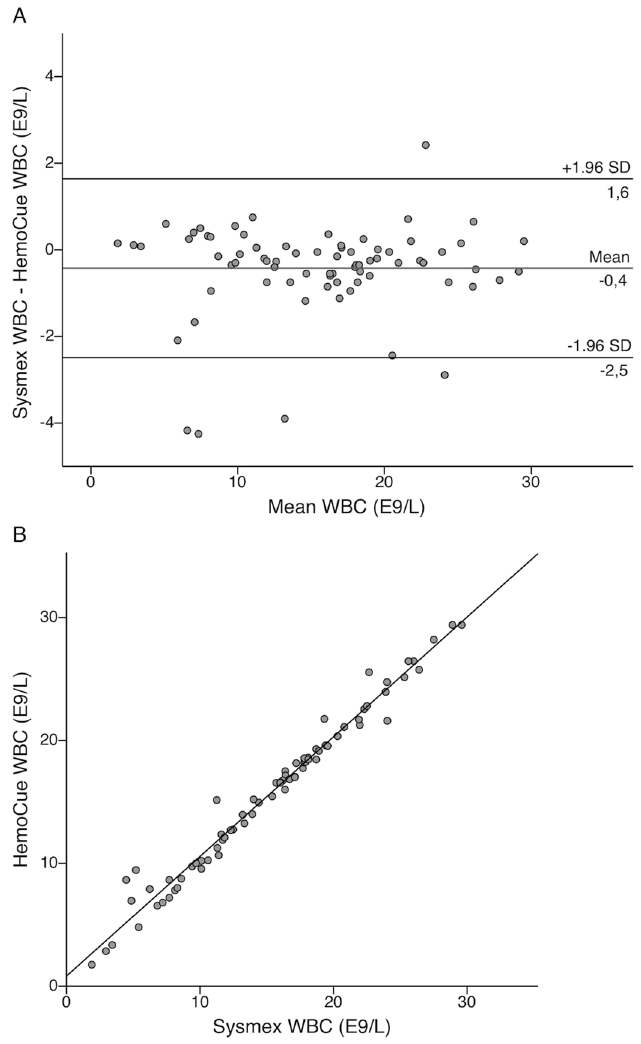
Fig 1. Bland-Altman and linear correlation plots for comparison of WBC methods in the laboratory. Bland-Altman plot presenting level of agreement (A) and a scatterplot showing linear correlation (B) between the HemoCue white blood cell (WBC) point-of-care test and Sysmex WBC results in 77 clinical blood samples. All testing was performed in the hospital ’ s central laboratory.